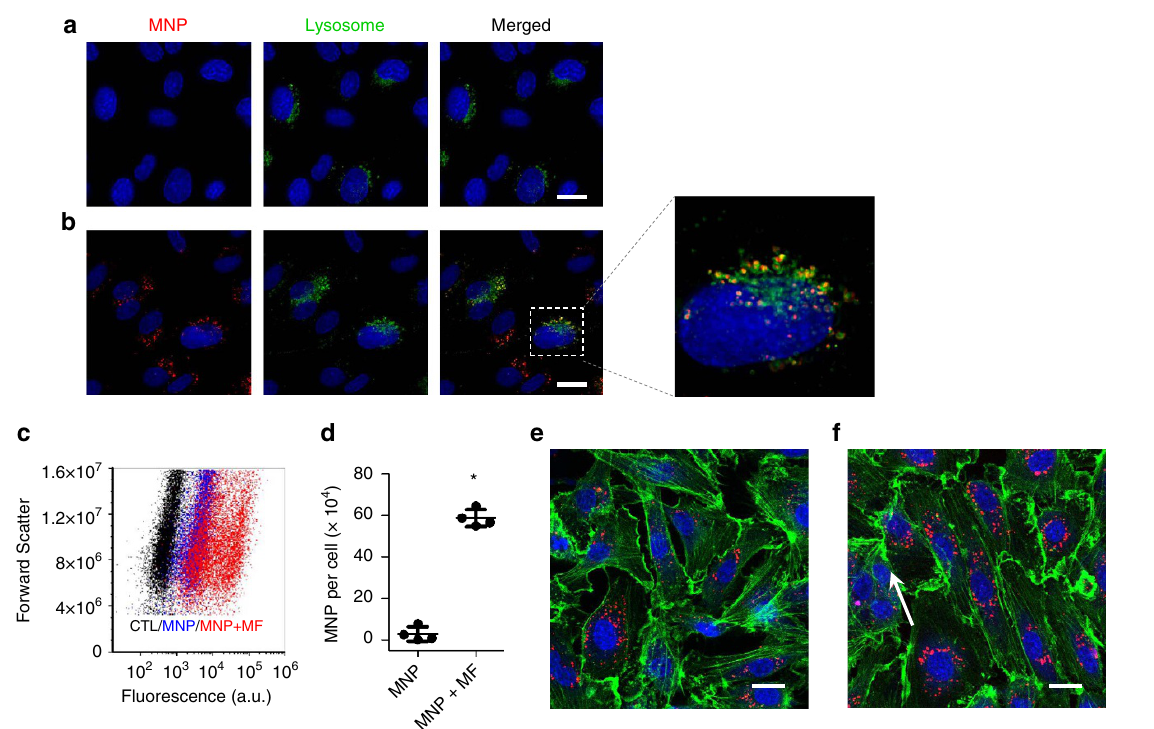
Figure 2 | The effect of magnetic force on endothelial cells in static culture. Endothelial cells were incubated with 16nm MNPs without ( a ) or with ( b ) a magnetic field. Magnetic force increased uptake of MNPs (red) by endothelial cells. Intracellular MNPs co-localized with lysosomes (green). Note that the lysosomes were stained based on virus-delivered transgene expression, which was uneven among transfected cells. Blue, nuclei. ( c ) Flow cytometry analysis of cellular uptake of MNPs without or with a magnetic field. ( d ) Quantification of intracellular MNPs by iron content (mean ± s.d.; n ¼ 4; * P o 0.05). Endothelial cells containing MNPs were further incubated without ( e ) or with ( f ) a magnetic field generated by an N52-grade rare-earth magnet ( W (cid:3) H (cid:3) L ¼ 1/2 00 (cid:3) 1/2 00 (cid:3) 1 00 ), respectively. ( e ) The stress fibres (green) of endothelial cells have a random orientation after internalizing MNPs (red). ( f ) After exposed to external magnetic force, stress fibres appear to align with the force (the arrow indicates the direction of magnetic force). Scale bar, 20 m